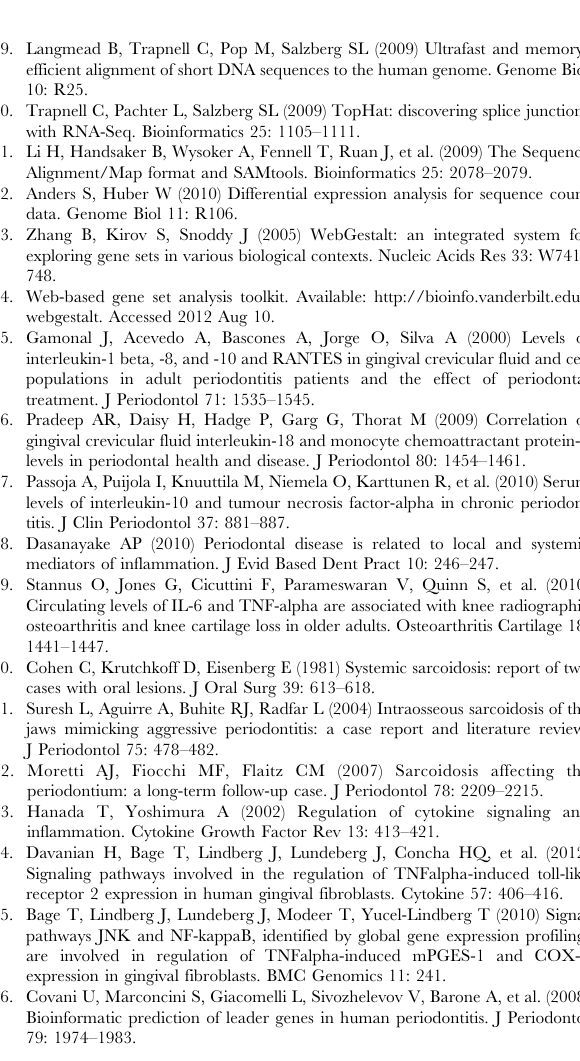
Table S1 Uniquely expressed genes within enriched path- ways in periodontitis-affected and healthy gingival tissues. TableS2 Fulllistofallsignificantlydifferentiallyexpressed genes in periodontitis-affected and healthy gingival tissues. Table S3 Gene Ontology enrichment analysis of differ- entially expressed